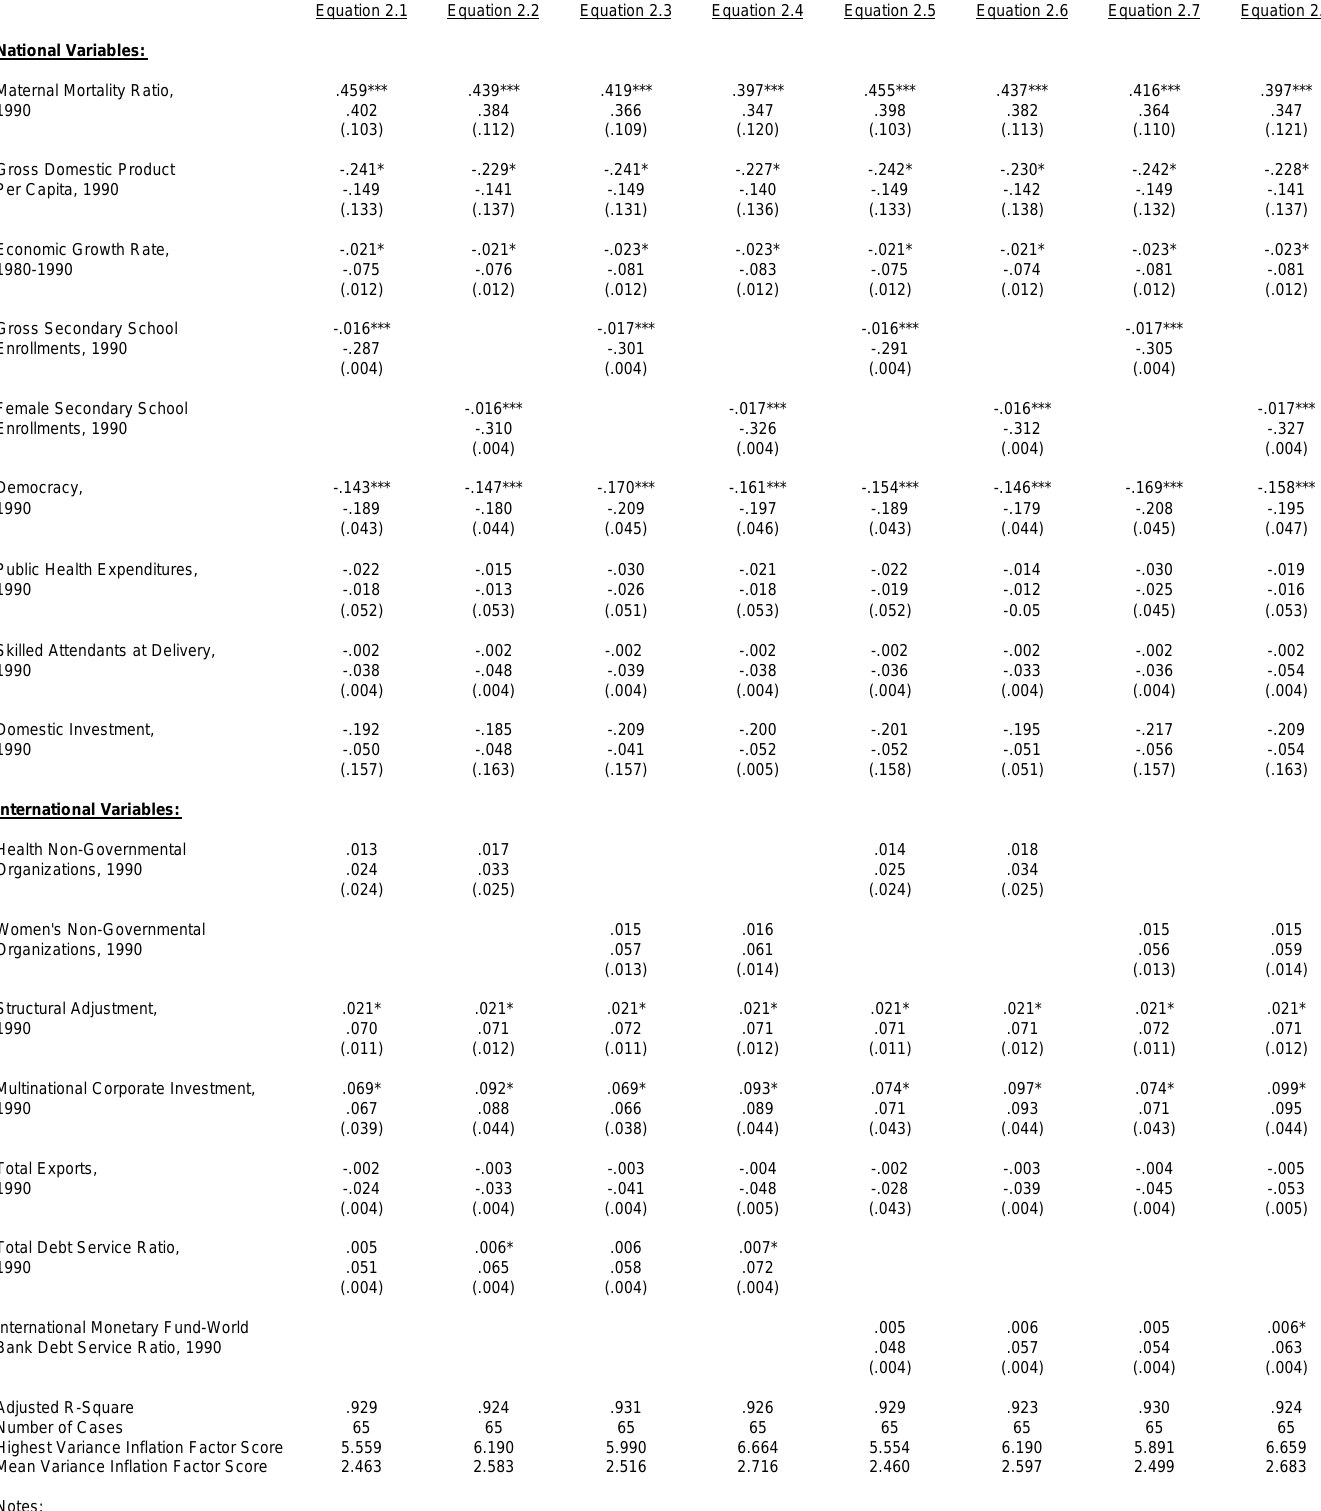
Table 2 Estimates of Maternal Mortality (1990-2005) Including Debt Service, Structural Adjustment, and Non-Governmental Organizations Equation